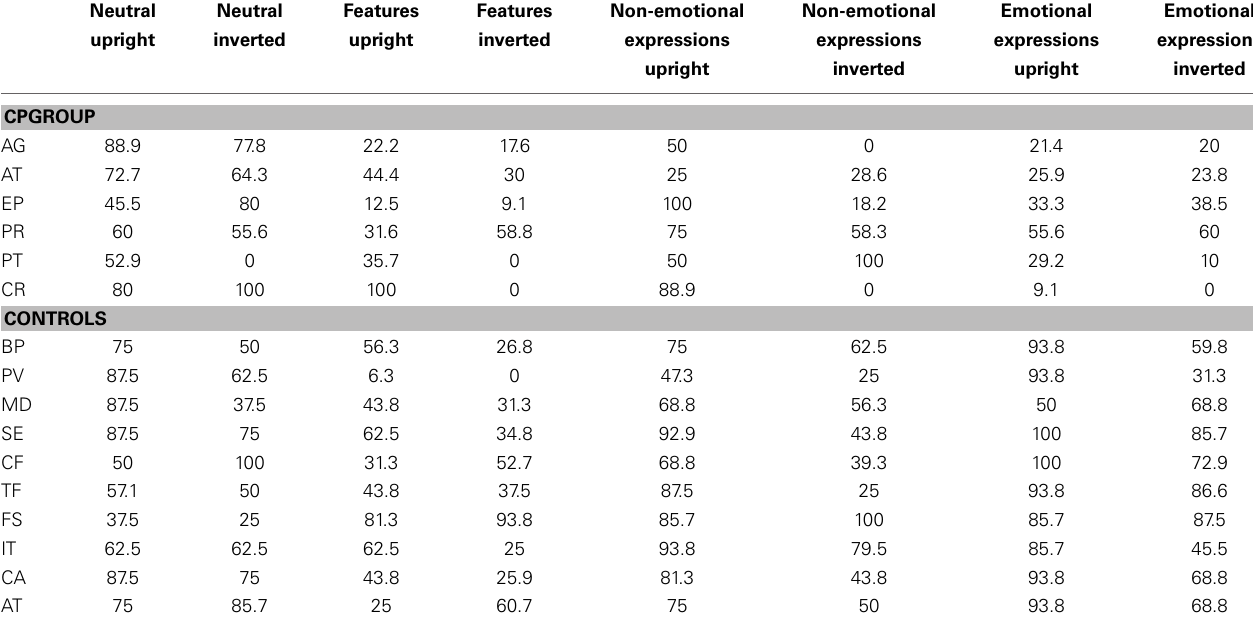
Table 4 | The mean percentages of correct responses for each participant subdivided for each condition in Task 2 (Change detection